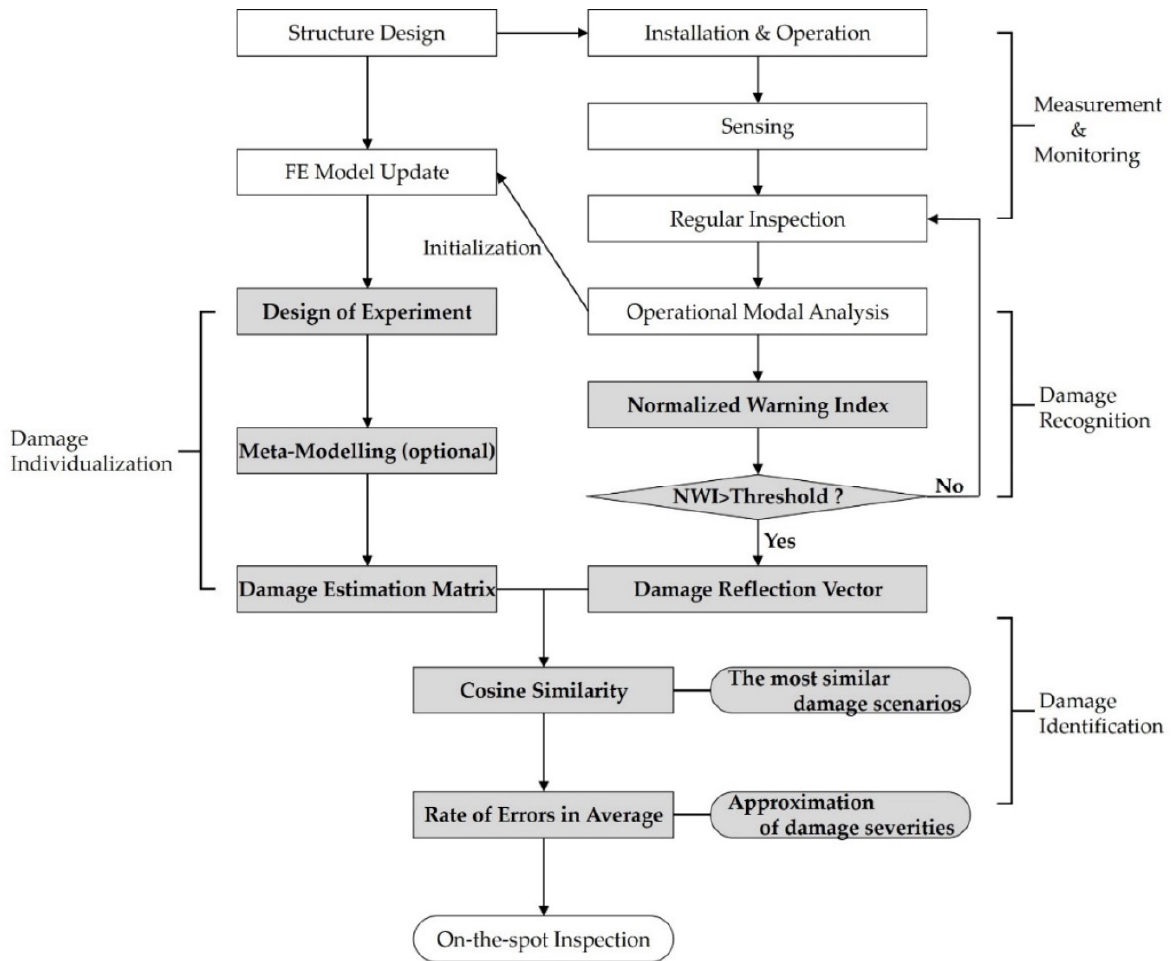
Figure 3. Entire flowchart of the cosine similarity ‐ based SHM [27].